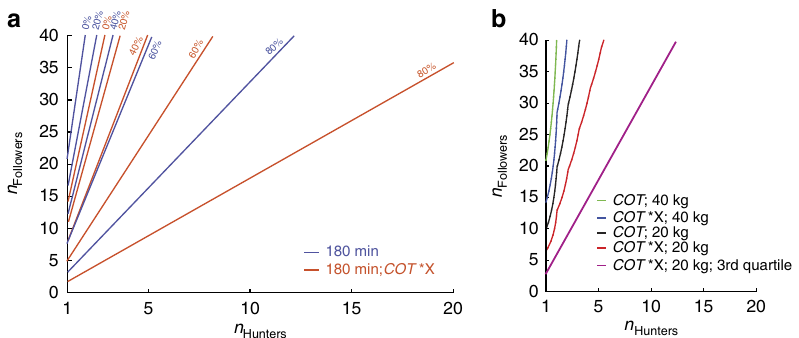
Figure 9 | Influence of different model parameters on model outcome. ( a ) Effect of kleptoparasitism and COT error analysis. Boundary on sustainable pack composition assuming a 180min limit on daily hunting time. Red lines indicate boundary (pack composition to the right of the line is sustainable) for different percentages of prey stolen (40kg, impala). Blue lines indicate sustainability for higher COT ( COT Low (cid:3) 2.5; COT High (cid:3) 1.5) based on ref. 47. ( b ) Sustainability boundary for 180min daily hunting time limit calculated for different COT 47 , prey size and abundance. Lower prey density simulated using the 3rd quartile for hunt distance (3.38km) and hunt duration